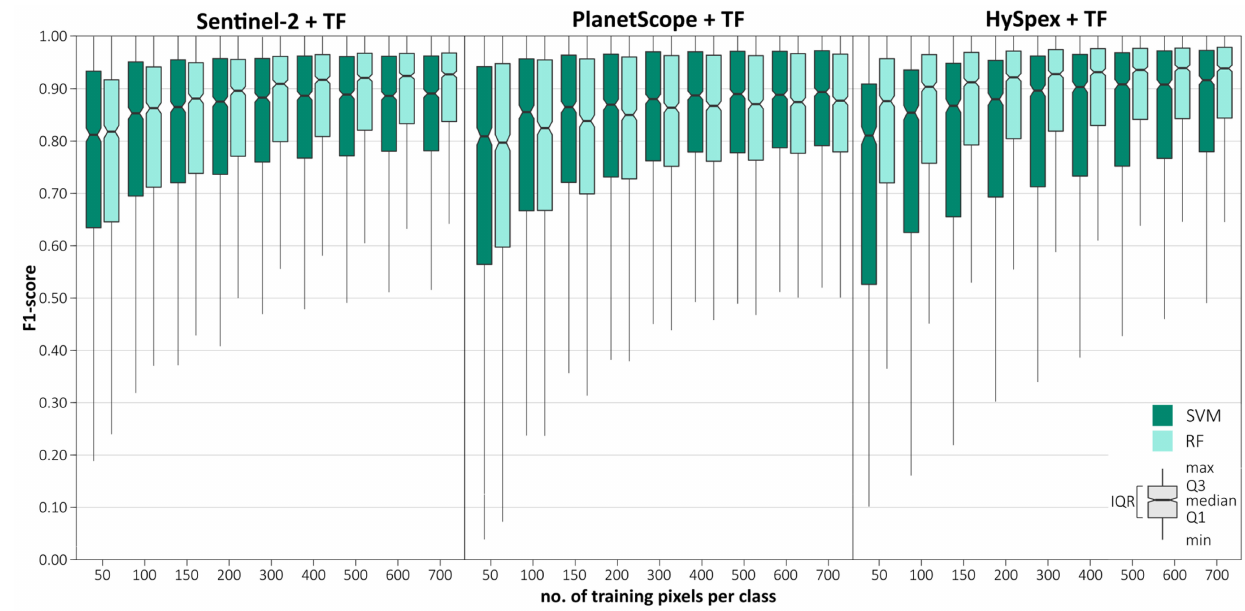
Figure 6. F1-score aggregated for all tree species (background classes excluded) depending on number of training pixels per class: random forest (RF) and support vector machine (SVM) classifiers; 100 iterations. IQR, interquartile range; Q1, lower quartile; Q3, upper quartile; TF, topographic features (digital elevation model, canopy height model, and slope and aspect maps).